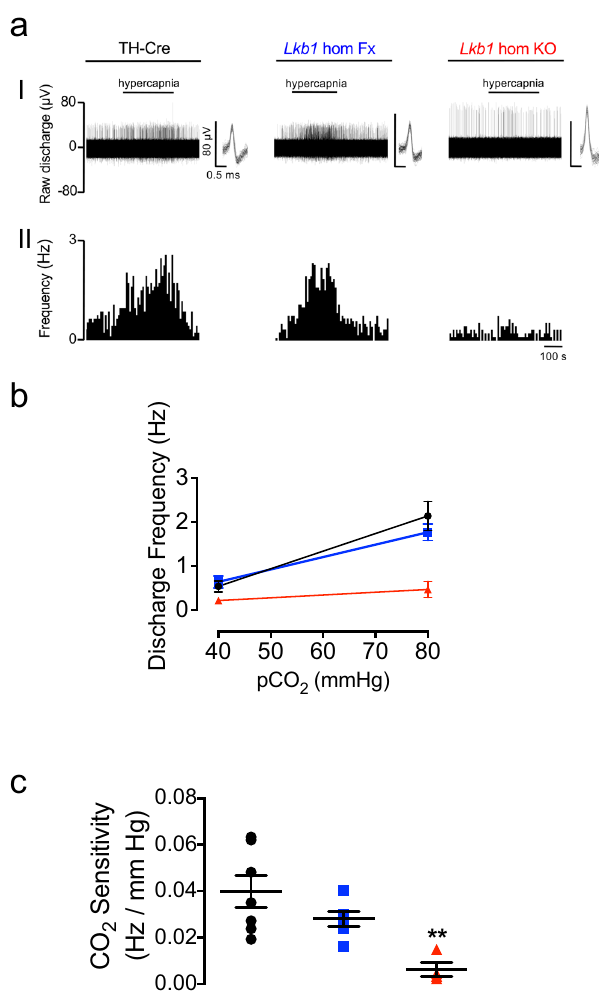
Fig. 3 Conditional deletion of Lkb1 in carotid body type I cells attenuates basal and hypercapnia-evoked afferent discharge from the carotid body in vitro. a shows (I) extracellular recordings of chemoafferent discharge versus time during normoxia/normocapnia and hypercapnia and (II) frequency-time histograms for carotid bodies from control (TH-Cre, black; n = 7 different carotid bodies), homozygous Lkb1 fl oxed ( Lkb1 hom Fx, blue; n = 6 different carotid bodies) and conditional Lkb1 homozygous knockout ( Lkb1 hom KO, red; n = 4 different carotid bodies) mice ( inset: single fi bre discriminations). b shows mean ± SEM for chemoafferent discharge versus P CO 2 . c Dot plots show mean ± SEM for CO 2 sensitivity for TH-Cre (black), Lkb1 hom Fx (blue) and Lkb1 hom KO (red). ** = p <